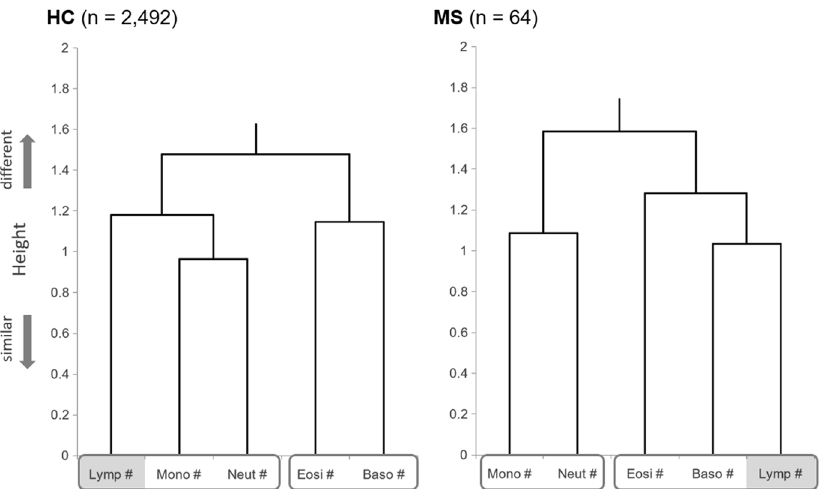
Figure 2. Dendrograms generated from Hierarchical Clustering of White Blood Cell Subtypes in the HC and MS Groups. The dendrogram generated for the HC group was with the distance of the lymphocyte count closer to monocyte and neutrophil counts than to eosinophil or basophil counts. Meanwhile, the dendrogram showed a different structure in the MS group, with the distance of the lymphocyte count closer to eosinophil and basophil counts. HC, healthy controls; MS, multiple